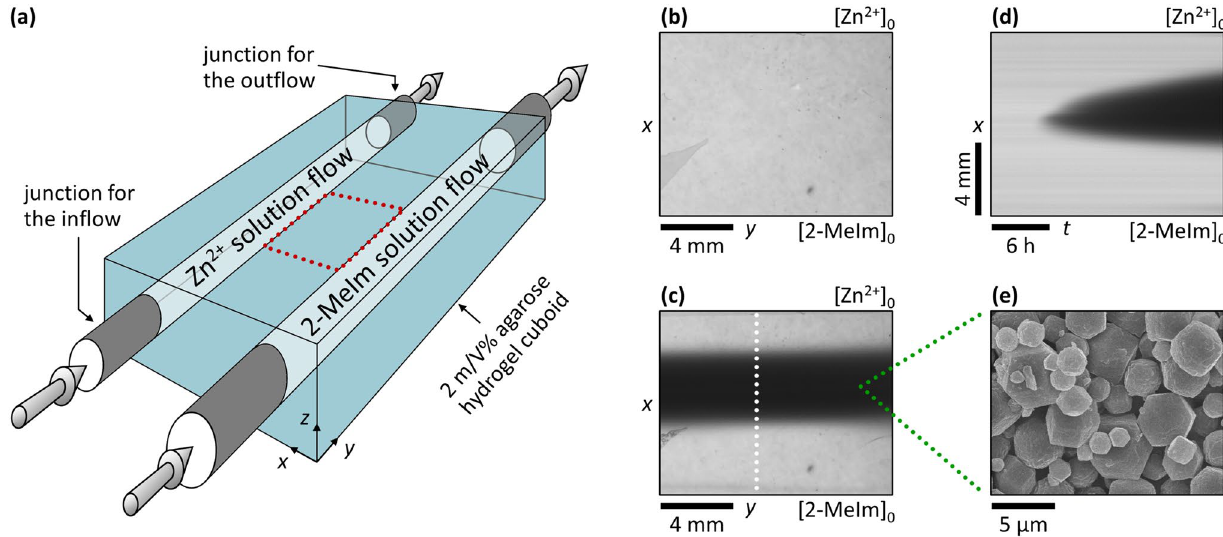
Figure 1. Synthesis of ZIF-8 crystals in a reaction–diffusion process at fixed antagonistic concentration gradients. Scheme of the gel reactor used in the synthesis ( a ), where 3D arrows represent the continuous flows of the fresh reagent solutions in the channels. Top view of the inter-channel zone (indicated by red dotted frame in ( a )) at t = 0 ( b ) and 24 h ( c ). Space–time plot of the evolution of the precipitation zone ( d ) obtained along the white dotted lines shown in ( c ). The white precipitate appears as black in the pictures because transmitted light was monitored. The labels [Zn 2+ ] 0 and [2-MeIm] 0 indicate the positions of the channels. A representative SEM micrograph of the particles isolated from the middle of the precipitate zone ( e ). The applied boundary concentrations were [Zn 2+ ] 0 = 11.25 mM and [2-MeIm] 0 = 112.5 mM,